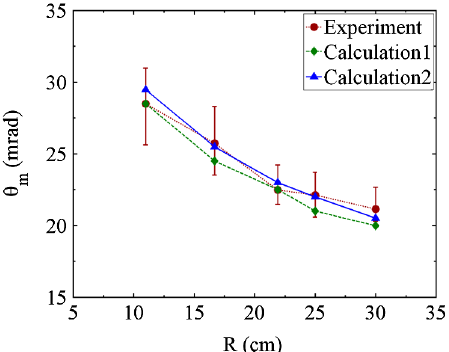
FIG. 8. Peak-intensity angles of CTR distributions for various distances. Calculation1 is obtained from a bunch form factor of the bunch distribution in Fig. 6(b), and Calculation2 is from the summation of the spatial intensities calculated by using the bunch form factors for the bunch distributions measured by the streak camera. Note that the spatial CTR image was summed up to 100